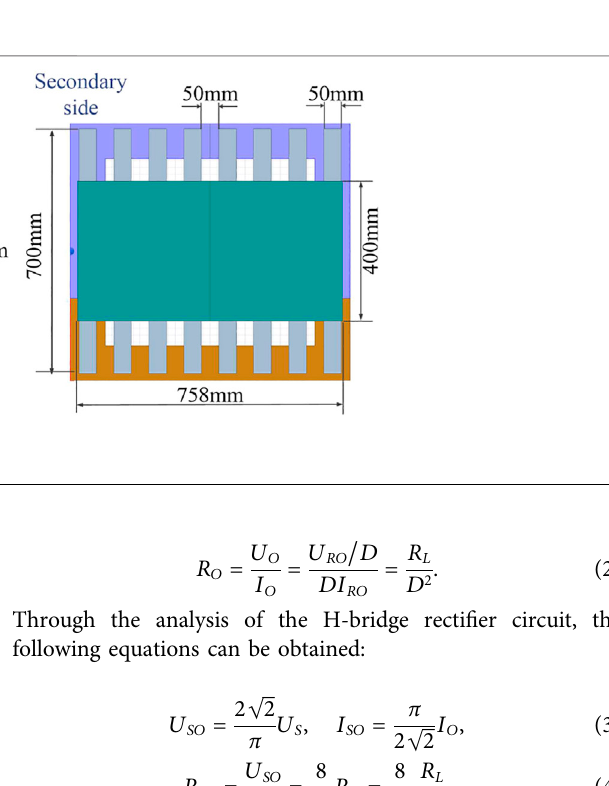
FIGURE 9 | Decoupling design of primary two coils.